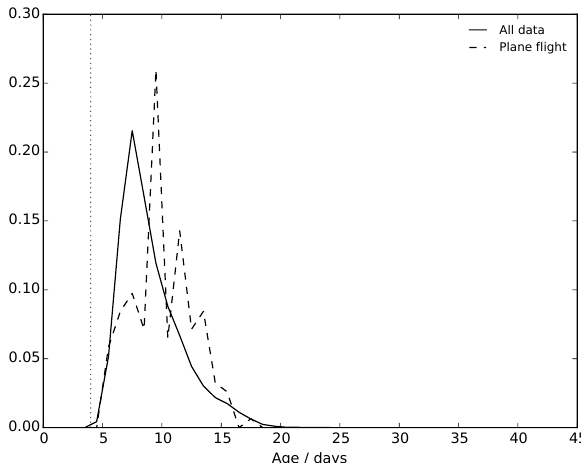
Figure B2. Probability distribution of the physical age of CH 3 I for the 3-D study domain (solid line) and as sampled by the air- craft (dashed line) between 11 and 15km during CONTRAST, 18 January–28 February 2014. The dotted line indicates 1 τ CH 4